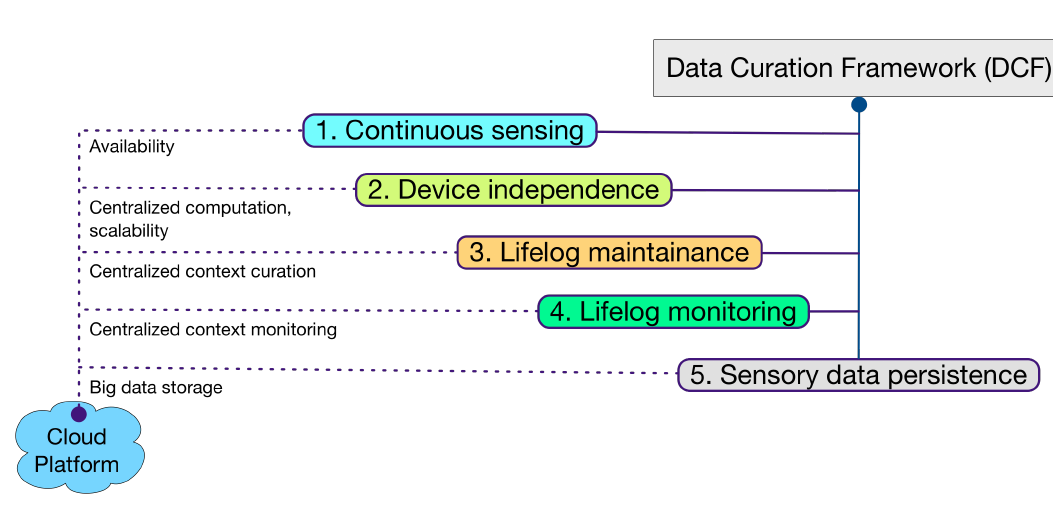
Figure 1. Data curation framework (DCF)